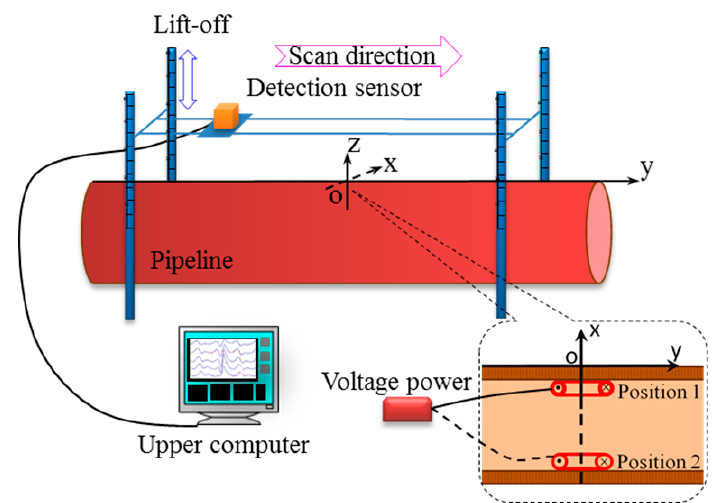
Figure 10. Experimental principle.